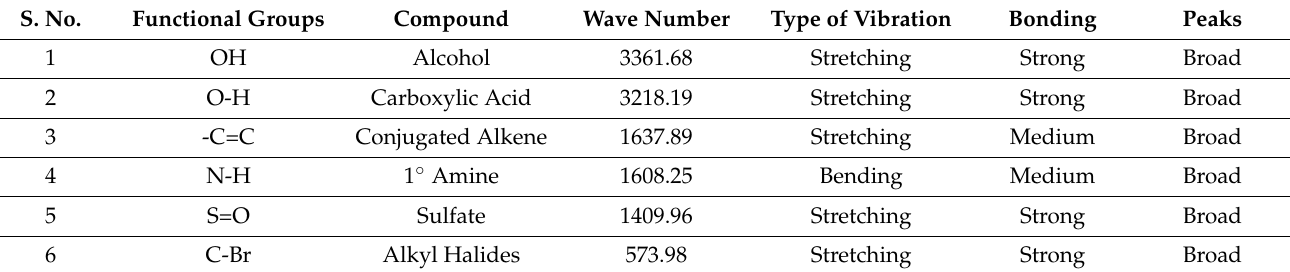
Table 1. FTIR spectra of ZnO NPs synthesized in A. indicae.